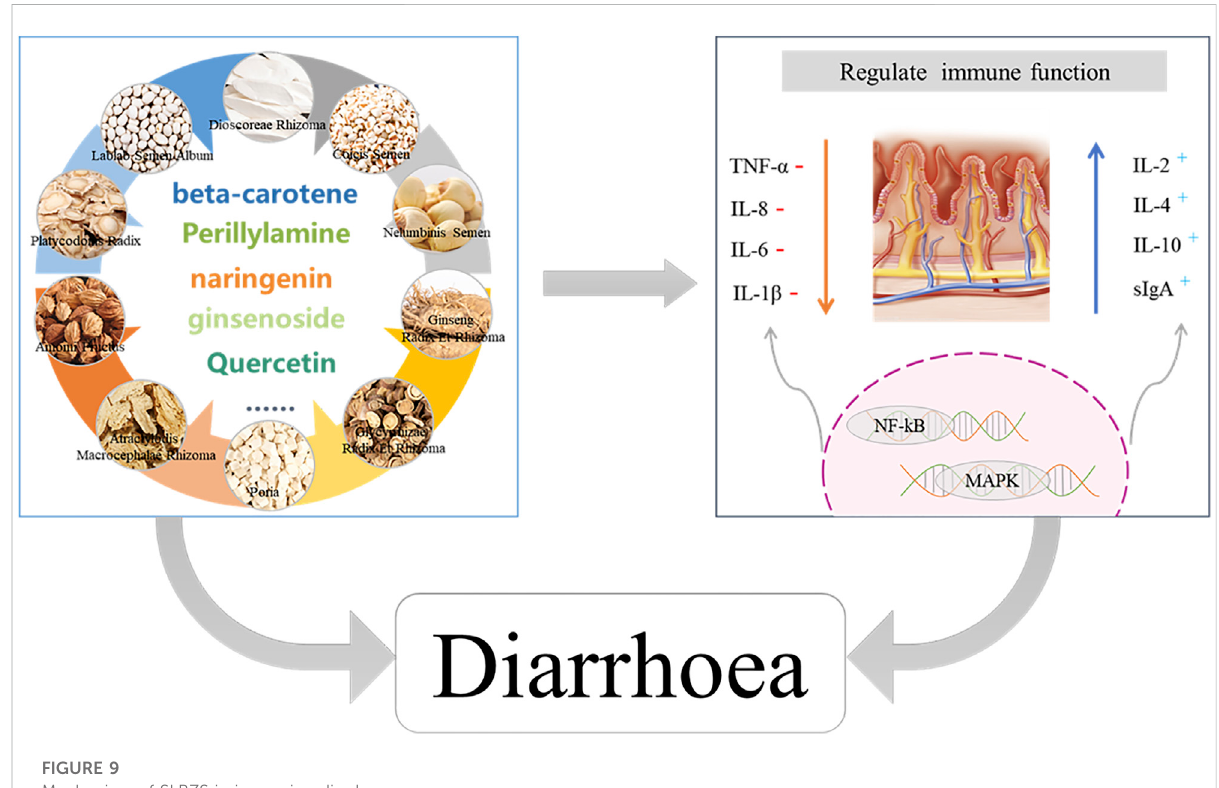
FIGURE 9 Mechanism of SLBZS in improving